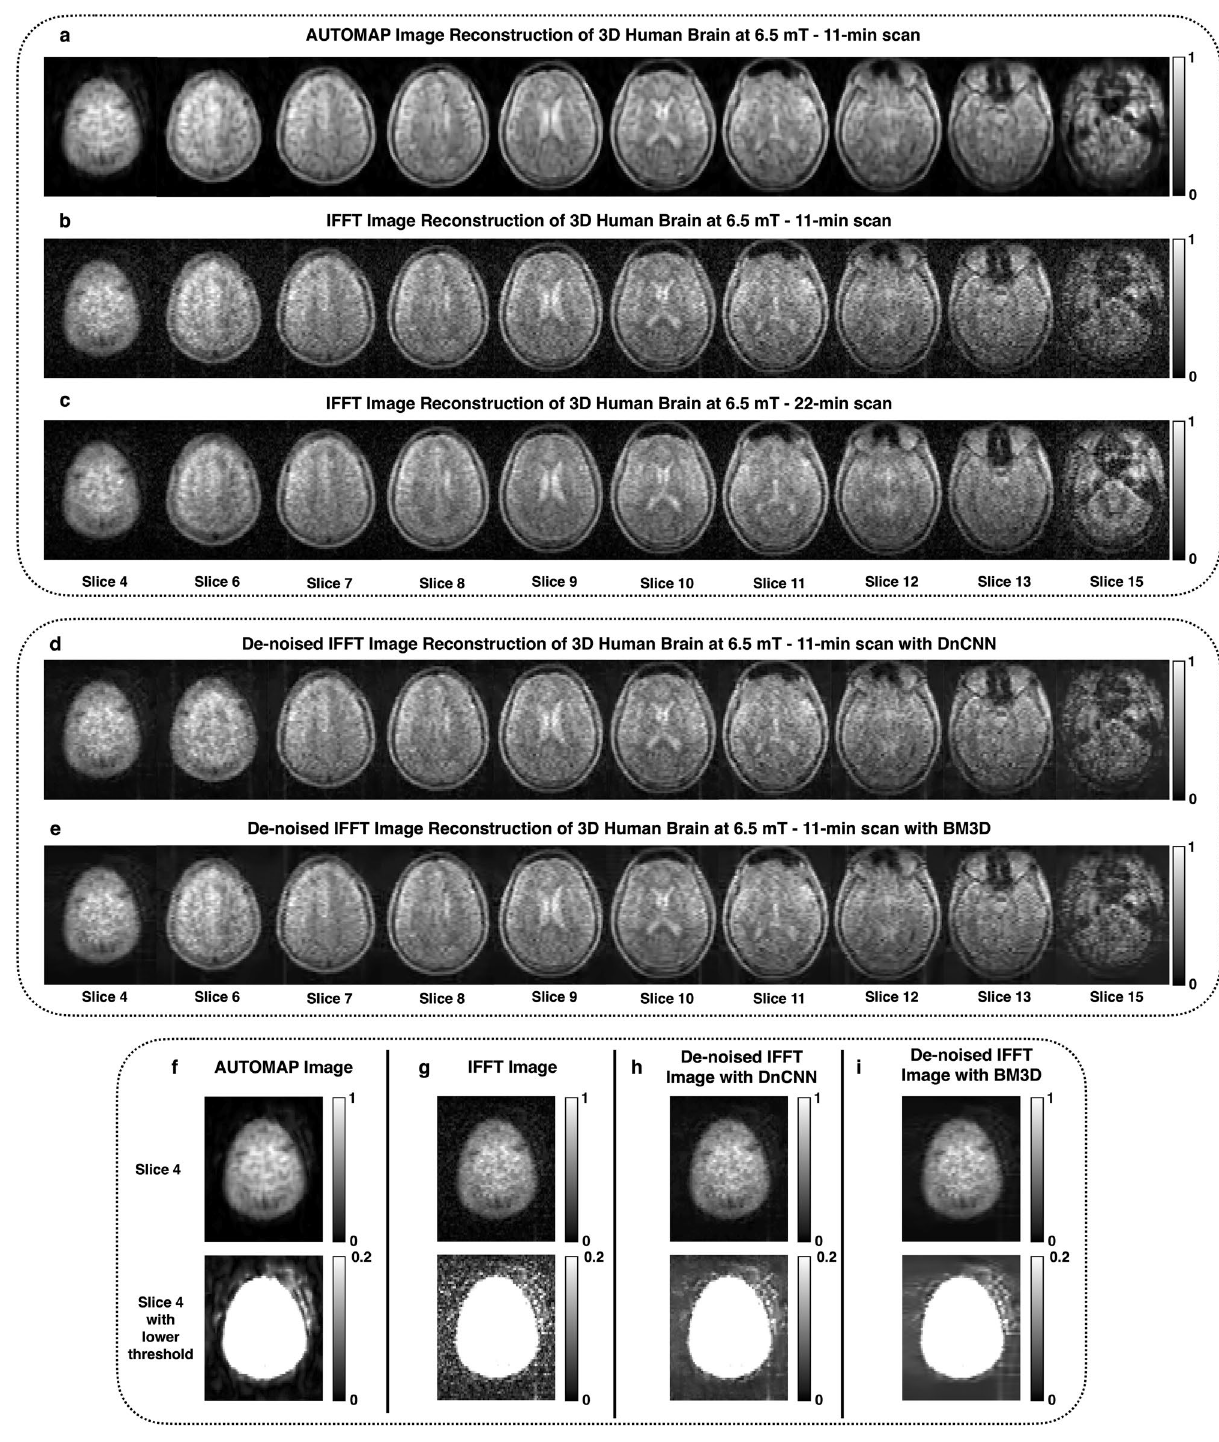
Figure 2. 3D brain image reconstruction at 6.5 mT using AUTOMAP compared to conventional IFFT with or without additional image-based denoising pipelines. ( a – c ) Reconstruction of 3D human head dataset—an 11-min (NA = 50) 3D acquisition dataset was reconstructed with AUTOMAP ( a ) and IFFT ( b ). Shown here are 10 slices from the full 15 slice dataset. For comparison, a 22-min (NA = 100) acquisition reconstructed with IFFT is shown in ( c ). The window level is unchanged in all images. ( d , e ) The two denoising algorithms (DnCNN and BM3D respectively) were applied to the IFFT reconstructed brain image (magnitude only) to compare to the denoising performance of AUTOMAP. ( f – i ) Noise floor comparison—Slice 4 from the NA = 50 reconstructed brain dataset shown above in ( a , b ) is displayed here with two different window levels: a normalized image on the top and a window level chosen to highlight the noise at the bottom. AUTOMAP is shown in ( f ), and IFFT is shown in ( g ). An additional DnCNN or BM3D image denoising step was applied to the image data reconstructed with IFFT ( h , i